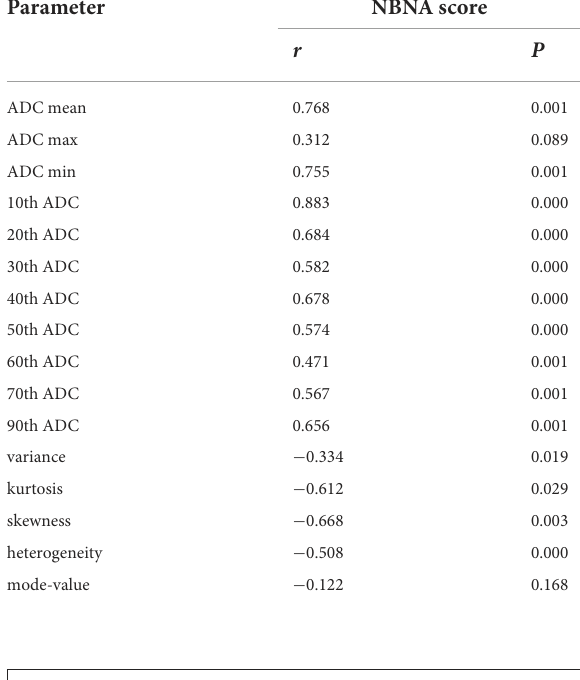
TABLE 3 Correlation between parameters and the NBNA value.